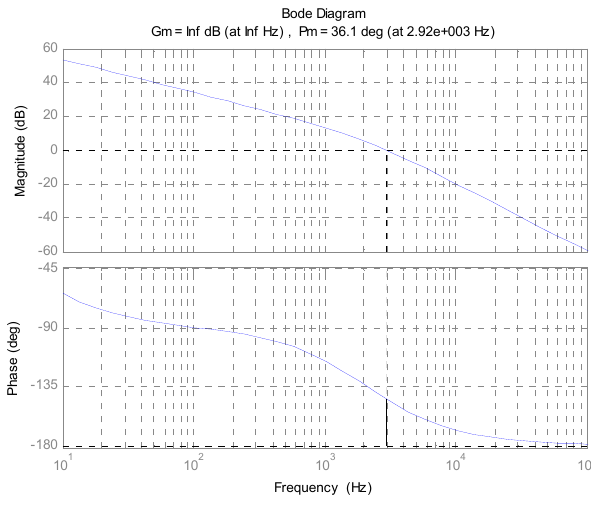
Figure 5. Bode plot of the plant.